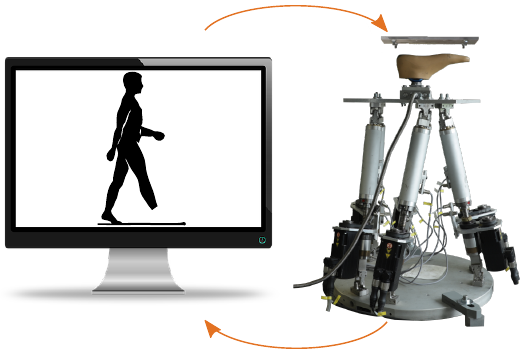
Figure 1. To investigate the gait dynamics of an amputee wearing a prosthesis, the application of HiL is proposed. The simulated amputee is coupled with the experimentally tested prosthetic foot. The coupling is achieved by an actuator (Stewart Platform in the figure) and a force–torque sensor. The prosthetic foot is moved by the actuator according to the calculations of the simulated amputee. The picture of the amputee is adapted from [12], license CC BY